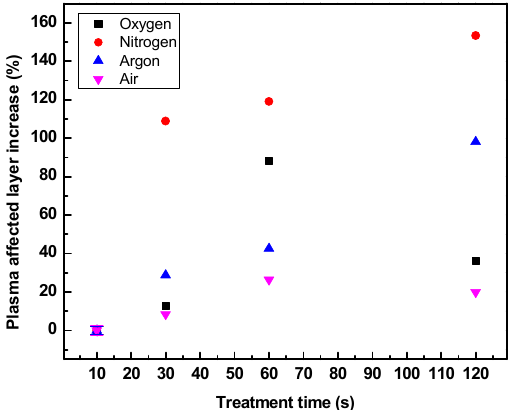
Figure 26. The change in % increase of plasma affected layer of LDPE with increasing treatment time.